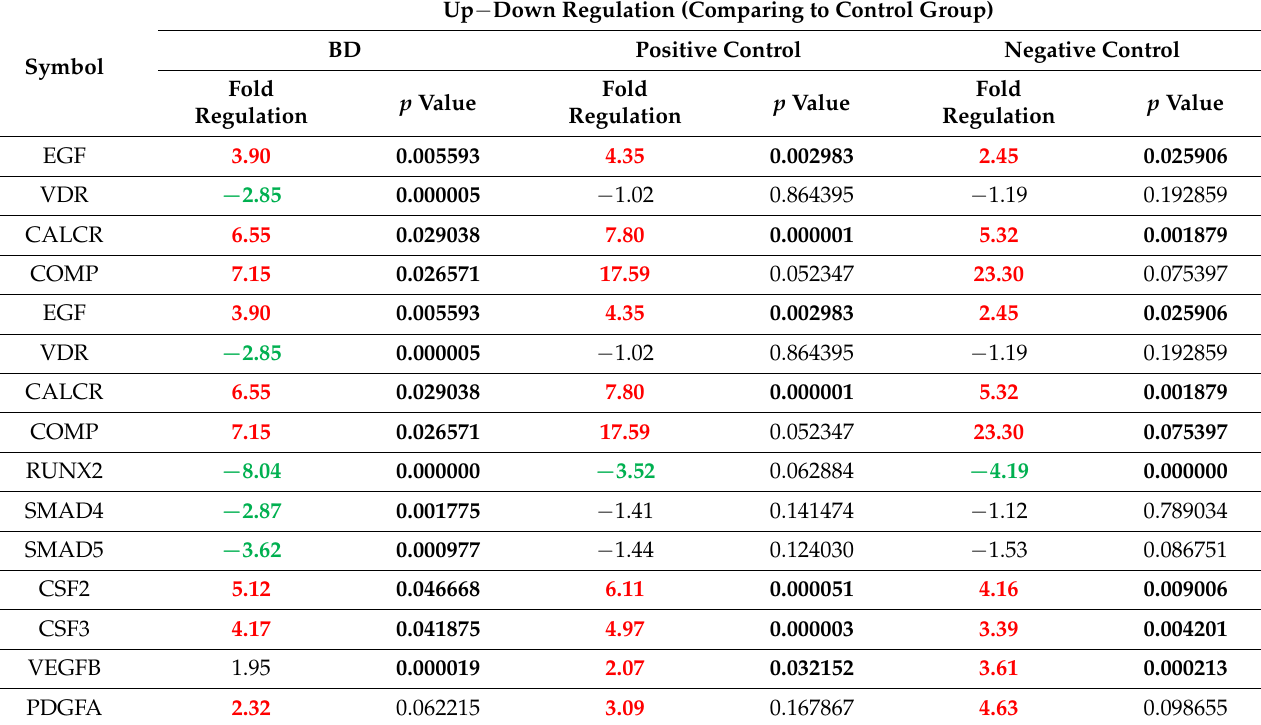
Table 3. PCR array results of fold changes and the statistical significance of genes, which are involved in Ca 2+ signaling and regulatory genes. All groups were compared to day 1 of treatment. All groups were compared to day 1of treatment. Red: upregulated genes, Green: Downregulated genes. The bold numbers represent significant p